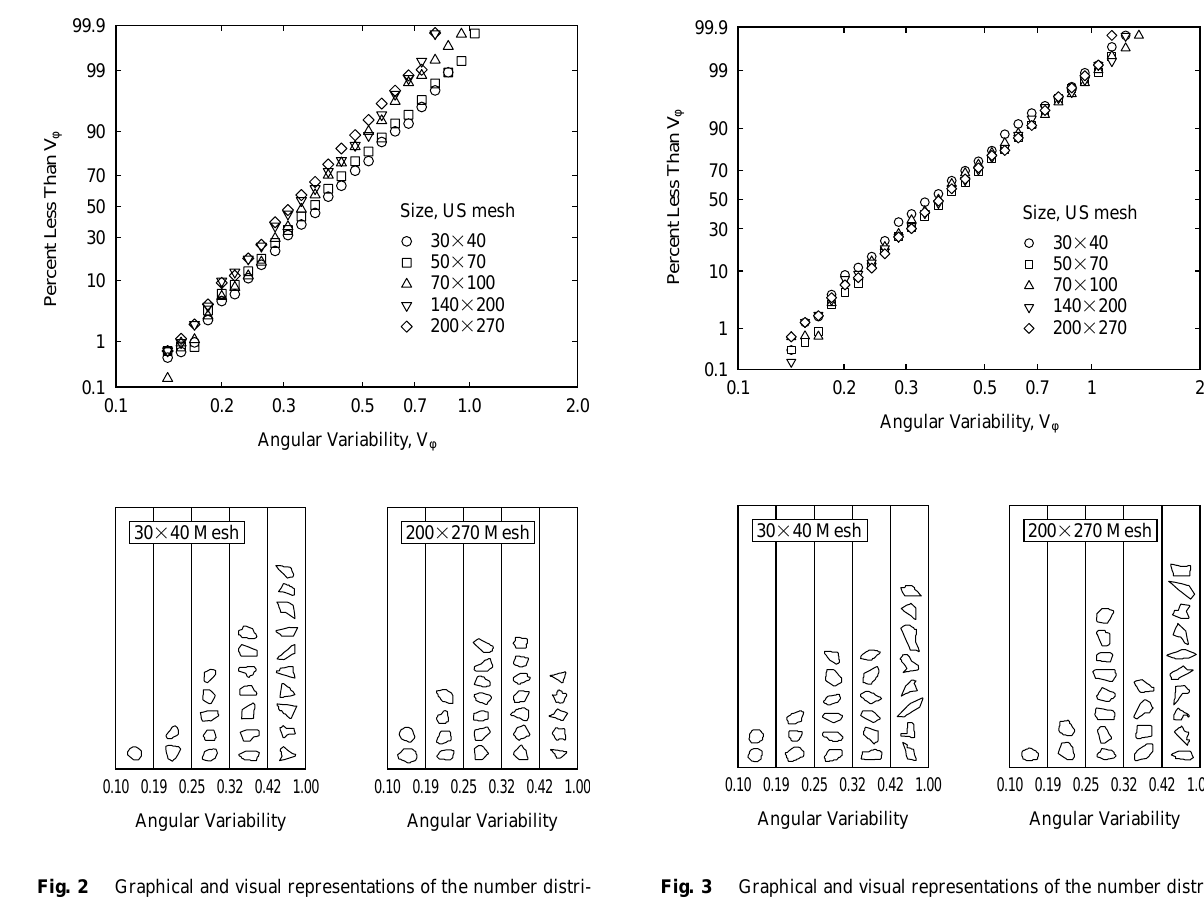
Graphical and visual representations of the number distri- butions of angular variability for quartz particles produced in a jaw crusher (feed size 9.5 (cid:7) 12.7 mm; gap setting 6.4